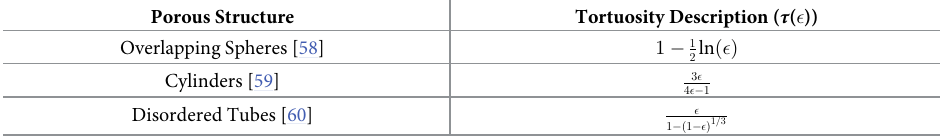
Table 1. Tortuosity expressions as a function of porous structures. Porous